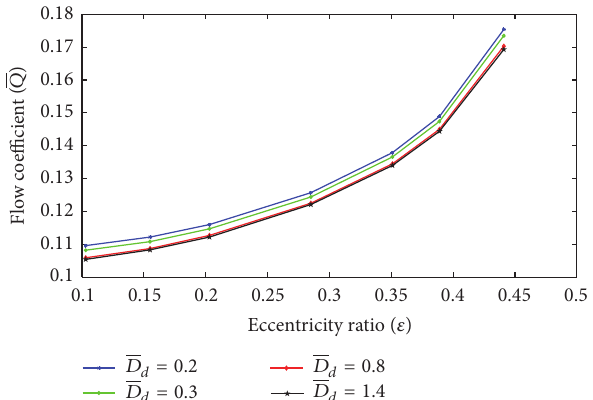
Figure 18: Effect of dam depth ratio on friction